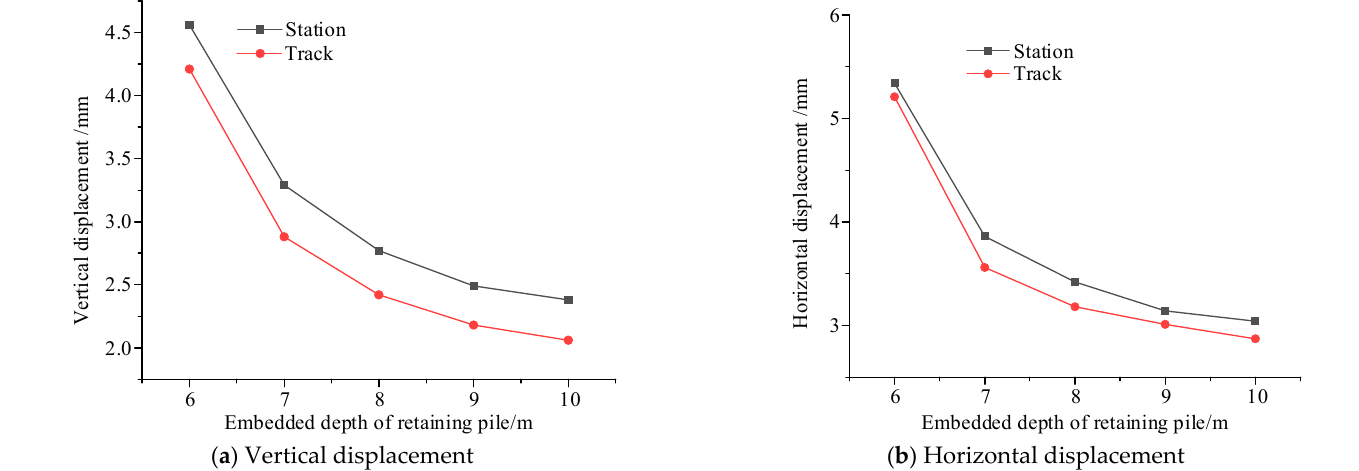
Figure 25. Maximum vertical and horizontal displacements of the station and track structures under different embedding depths.